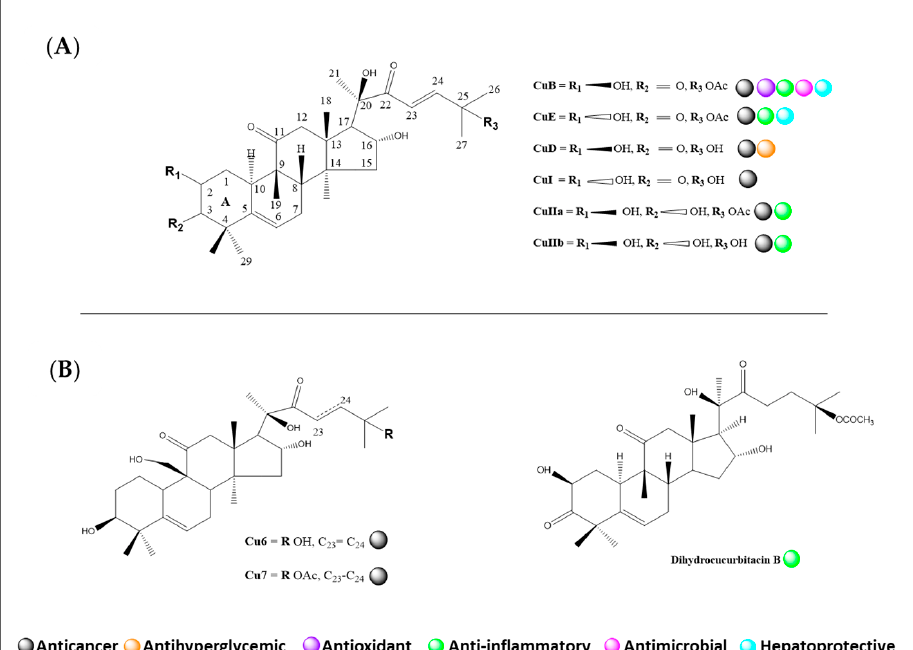
Figure 1. Overview of the chemical structure and biological properties of cucurbitacins. ( A ) The basic structure of this class of molecules is the core of cucurbitan (19-(10 → β )-abeo-10 α -lanost-5-ene), enumerated in the molecule’s center. Some of the main cucurbitacins in natural products are CuB, CuE, CuD, CuI, CuIIa, and CuIIb. The main differences are in the substitution pattern of ring A (C1–C5) and the side chain, where there may be unsaturation (C23–C25) and acetyl groups (C25). Additionally, alpha and beta hydroxyls are present at C2, C3, C7, C9, C16, and C20–C25. At the same time, unsaturation occurs at C23–C25, and the presence of keto groups in C2, C3, C11, C15, and C22. ( B ) Some derivatives important for their biological effects are shown.